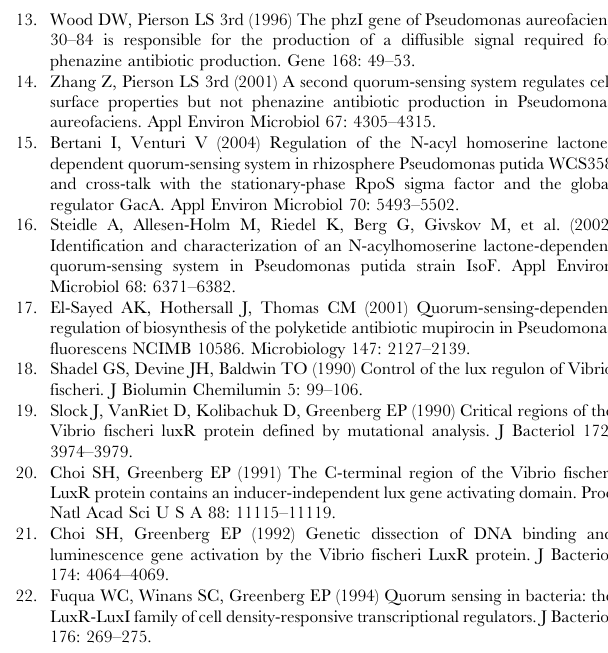
Table S1 Plasmids used in this study. Table S2 List of oligonucleotide primers used in this study. Table S3 Flanking genes to psaR1 , psaR2 and psaR3 in Pseudomonas syringae pv. Actinidiae